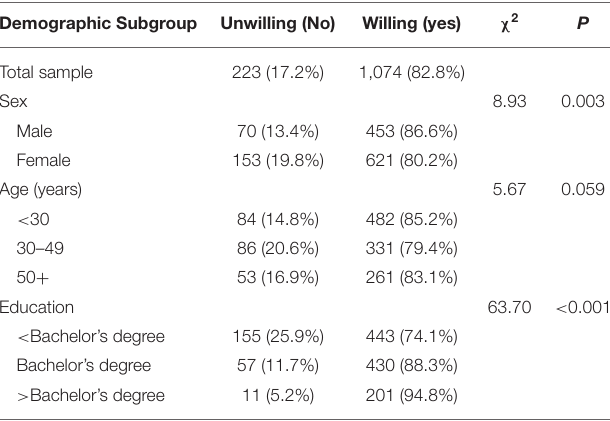
TABLE 2 | COVID-19 vaccination willingness in general and by subgroup among unvaccinated participants ( n = 1297). Demographic Subgroup Unwilling